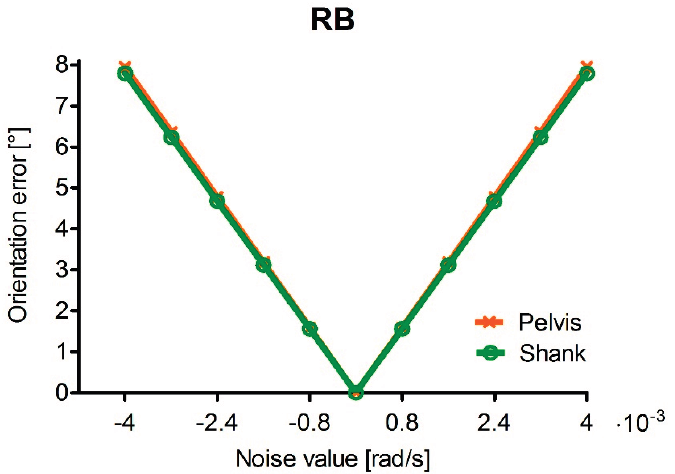
Figure 6. Orientation error associated to an RB aligned with the mean direction of the angular velocity in the shank as a function of noise levels for the ideal pelvis (orange) and shank signals (green). The abscissa indicates the magnitude of the noise level values. (Please note that a multiplication factor of 10 − 3 is reported on the right of the